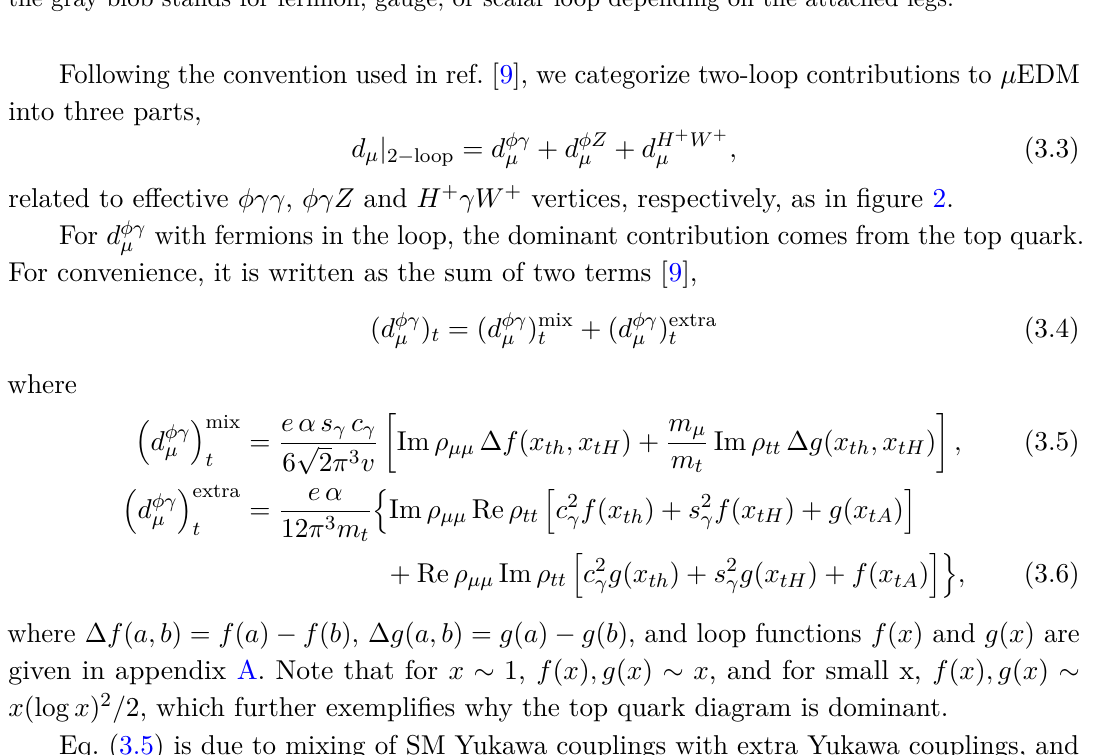
Figure 2 . Typical two-loop diagram for µ EDM, where φ ( H ± ) is a neutral (charged) scalar, and the gray blob stands for fermion, gauge, or scalar loop depending on the attached